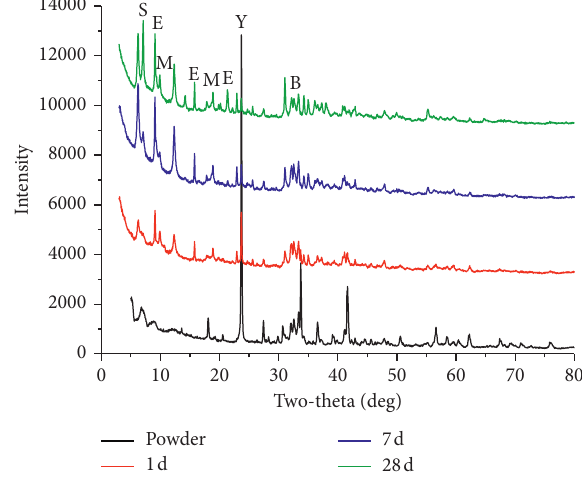
Figure 2: XRD pattern of CSA cement powder and hydrated CSA cement pastes cured at 21 ° C for 1d, 7d, and 28d. S, str¨atlingite; E, ettringite; M, monosulfate; Y, Ye’elimite; B, belite.